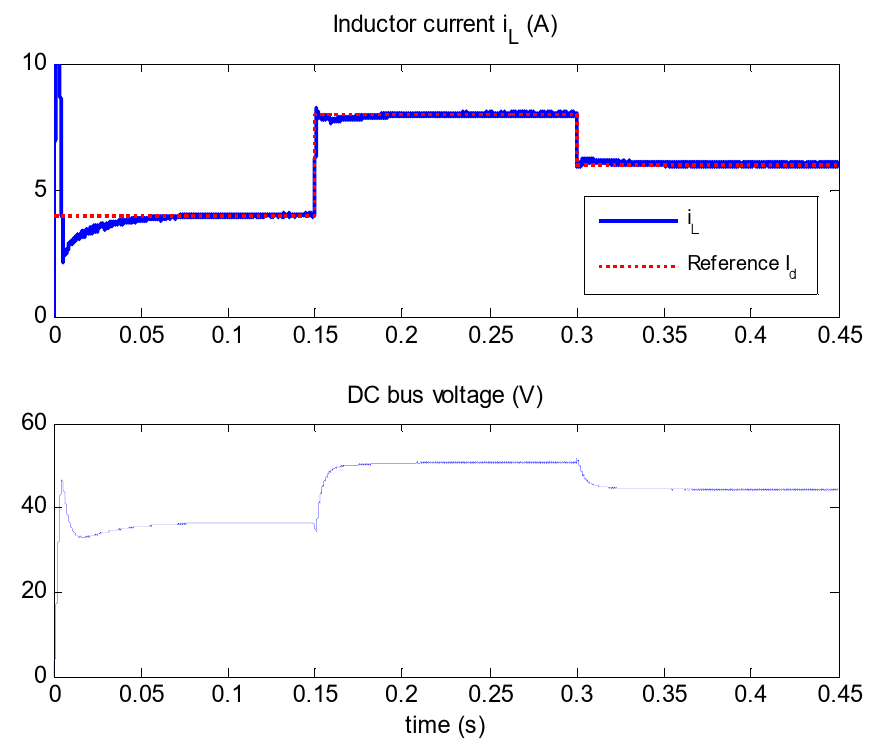
Figure 13. Tracking behavior of the inner loop controller in the presence of a time-varying reference